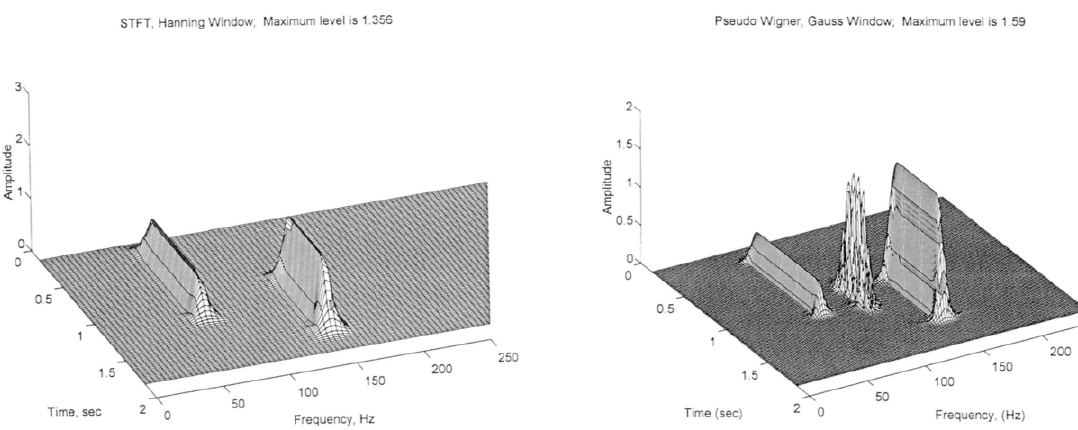
FIGURE 4 Pseudo-Wigner transform of Twosines with Gaussian